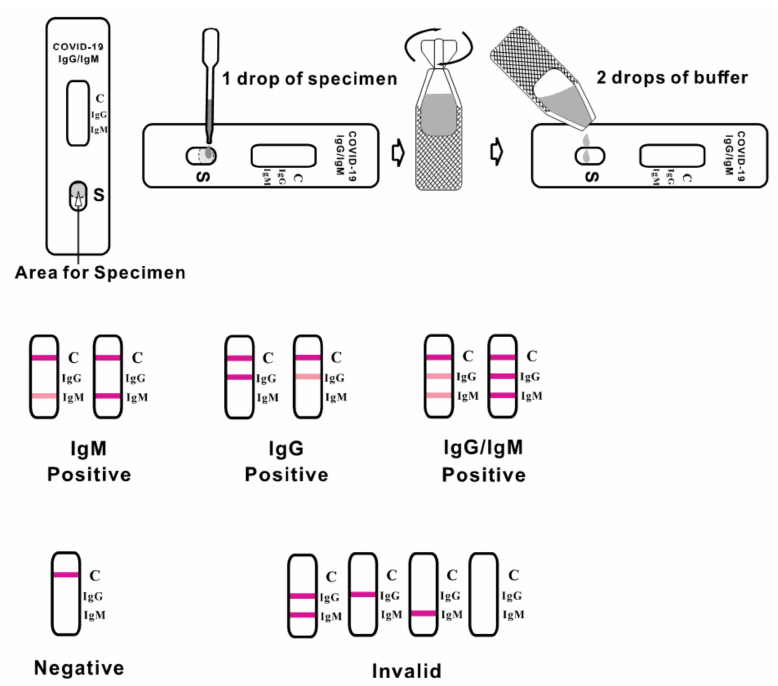
Figure 1. CLUNGENE ® Point-of-Care test manufacturer’s instructions.